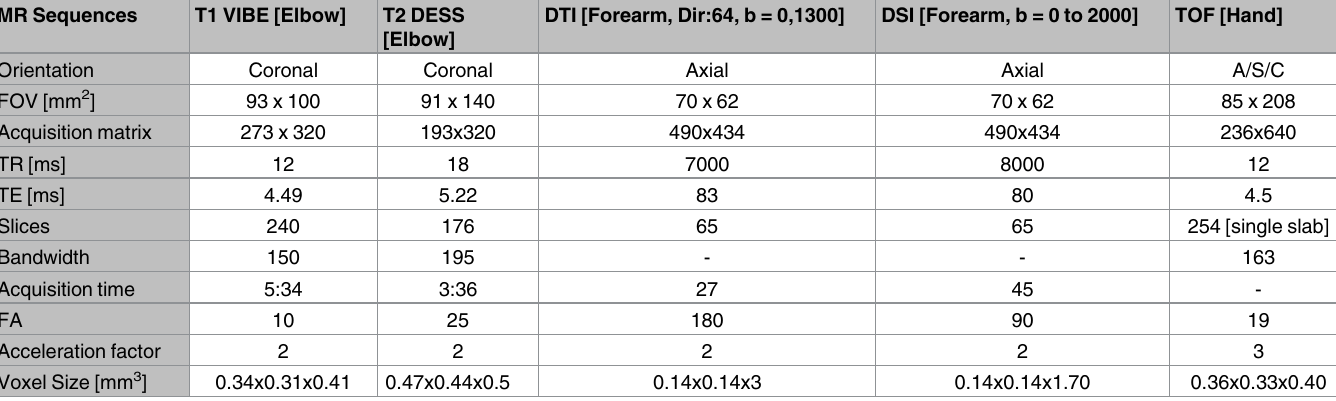
Table 2. 7T in-vivo imaging protocols for elbow, forearm, and hand [Figs 3 and 5–9;T1VIBE, T2 DESS, T2 * SWI, DTI, and TOF]. MR